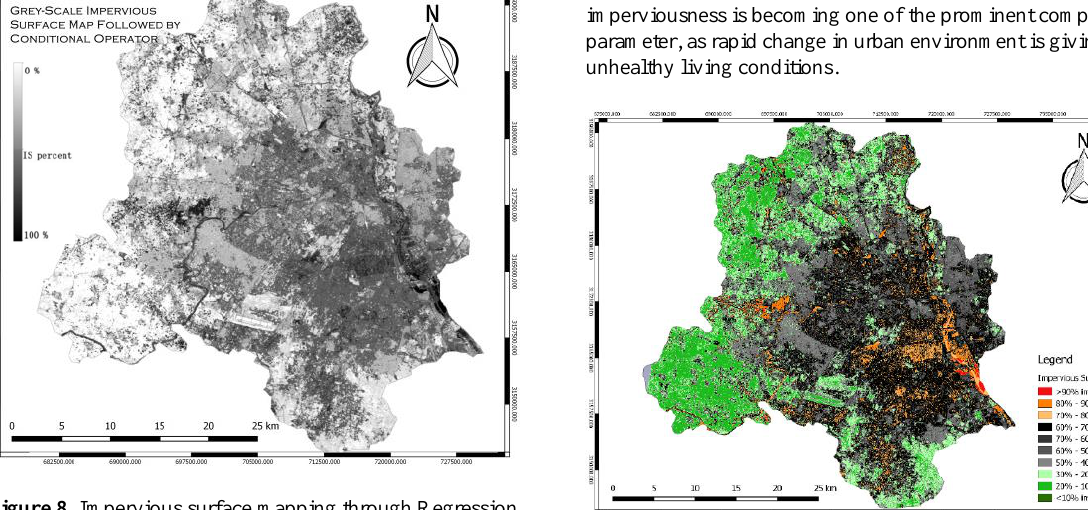
Figure 8 . Impervious surface mapping through Regression modelling